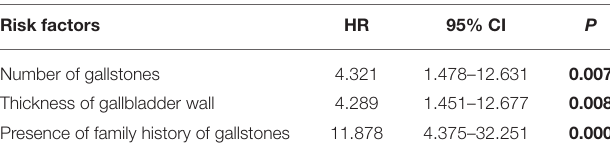
TABLE 3 | Results of Cox regression analysis of postoperative gallbladder stone